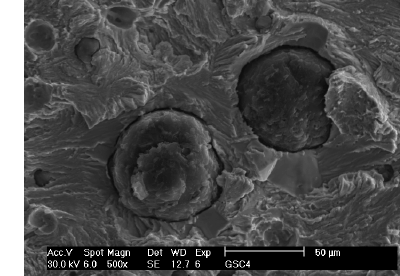
Figure 41: Ferritic-pearlitic DCI (R = 0.1,  K = 15 MPa √ m).